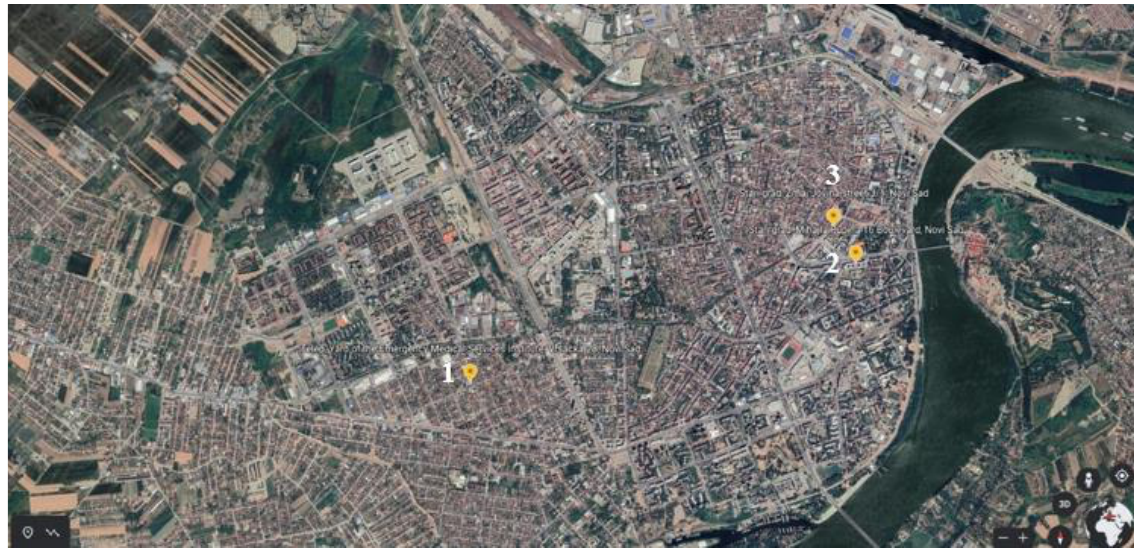
Figure 1. Map of noise measuring points in the "zone of the city center and city roads" in Novi Sad: 1 − Telep, Vršačka 28; 2 − Stari grad, Bulevar Mihajla Pupina 16; 3 − Stari grad, Zmaj Jovina St.